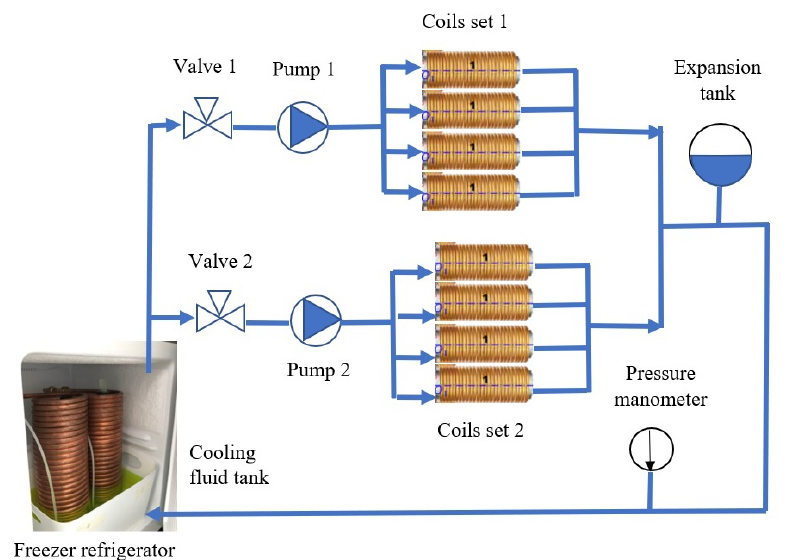
Figure 16. Cooling system for temperature control of